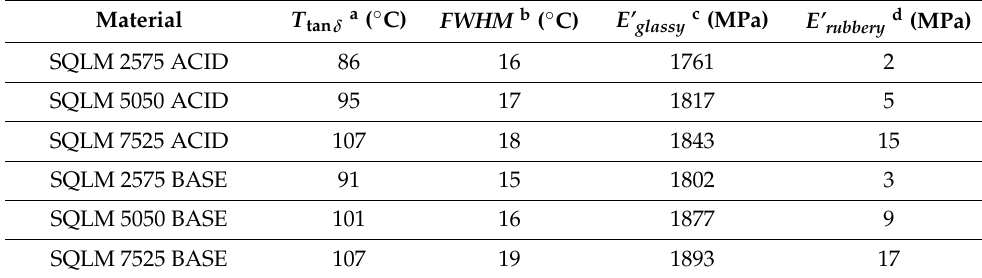
Figure 4. Evolution of tan δ and storage modulus with the temperature of the different materials prepared with acid ( a , b ) and basic catalysts ( c , d ). Table 3. Main data obtained from DMTA analysis of the materials prepared .